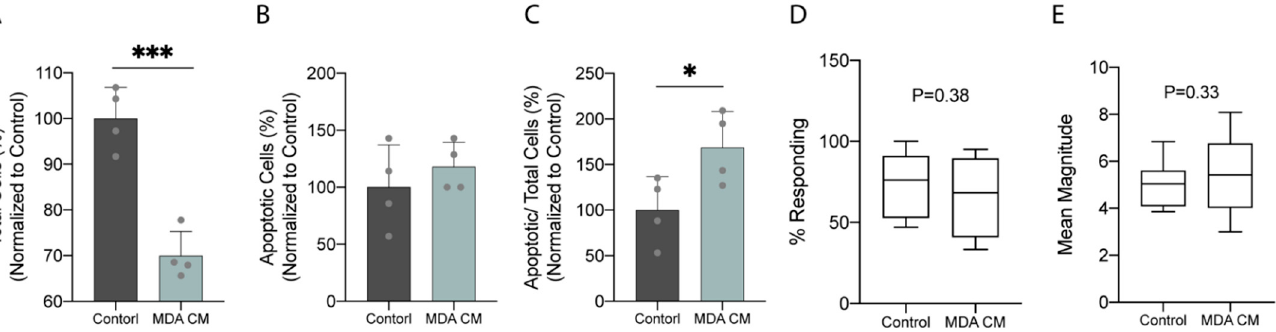
Figure 7. Breast cancer cells stimulated with combined treatment decreased the percentage of apop- totic osteocytes but showed no significant effect on the intracellular calcium influx of osteocytes in response to OFF. ( A ) Total MLO-Y4, ( B ) apoptotic MLO-Y4, and ( C ) apoptotic MLO-Y4 over total MLO-Y4 after 3-day incubation of MLO-Y4 in CM from MDA-MB-231 stimulated with DMSO, mon- otreatments, or combined treatment ( n = 10). Normalized to DMSO control. ( D ) Intracellular calcium response percentage and ( E ) mean magnitude of MLO-Y4 under 2 Pa OFF after 3-day incubation of MLO-Y4 in CM from combined treatment stimulated MDA-MB-231 compared to DMSO ( n = 7–8). * p < 0.05.